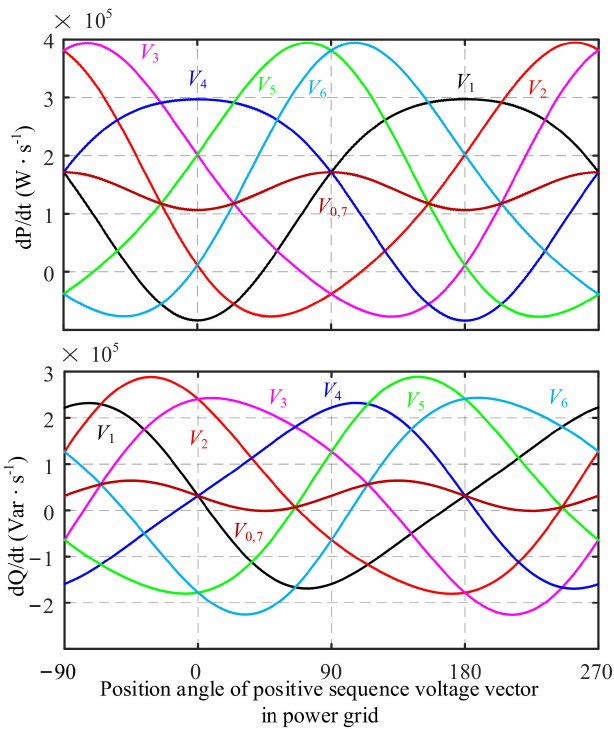
Figure 2. New instantaneous power slopes of various rectifier voltage